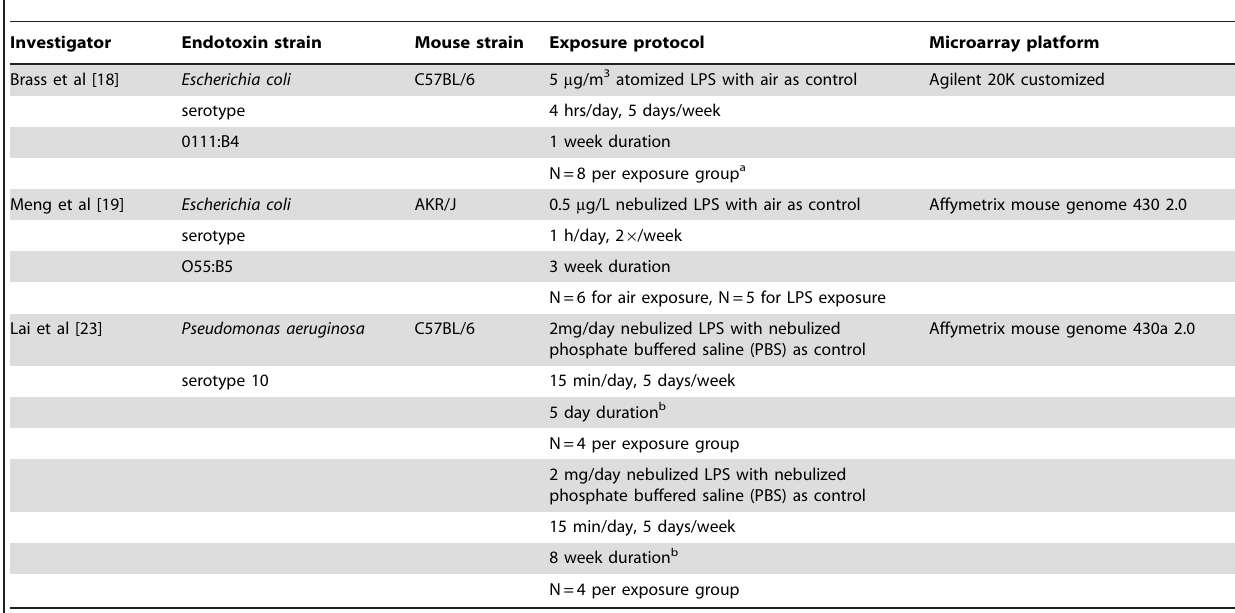
Table 1. Description of all included studies including differences by endotoxin strain, mouse strain, exposure protocol, and microarray platform